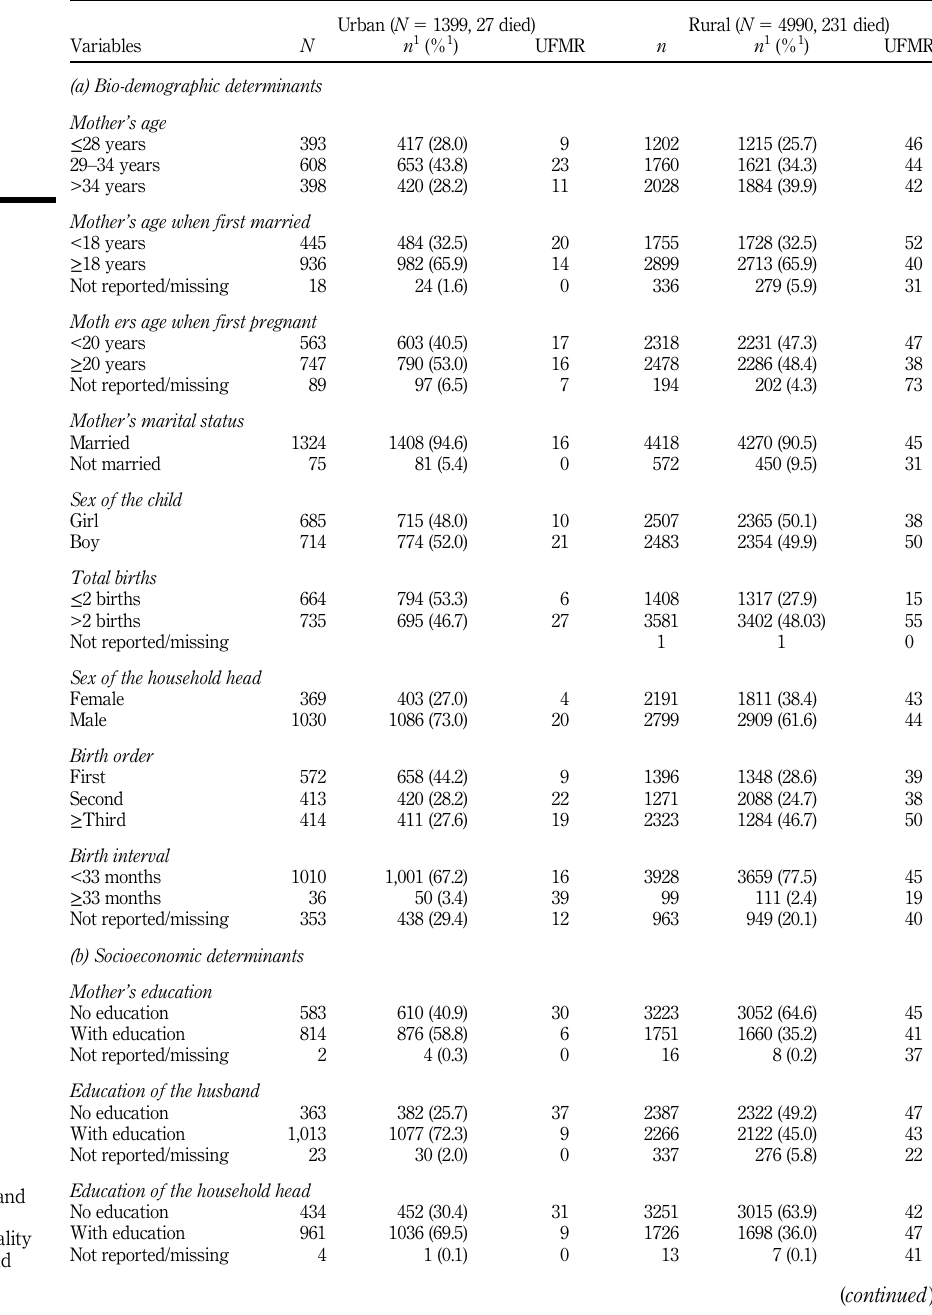
Table 1. Characteristics and distribution of under-five mortality rate in urban and rural